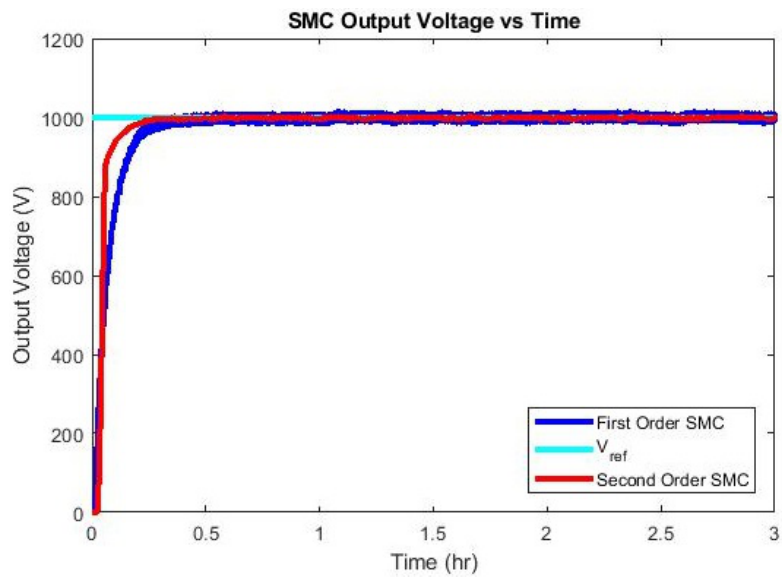
Figure 23. SMC buck-boost converter output voltage at 1000 W/m 2